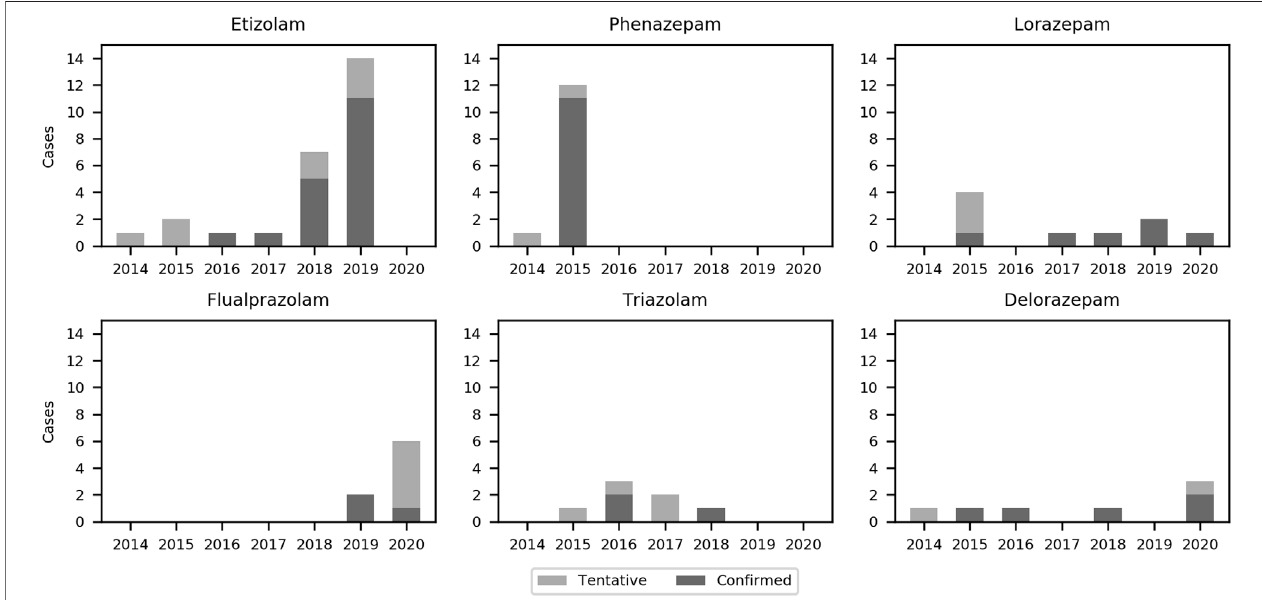
FIGURE 8 | Bar chart of the six most frequently detected designer benzodiazepines in the present study from 2014 to 2020.